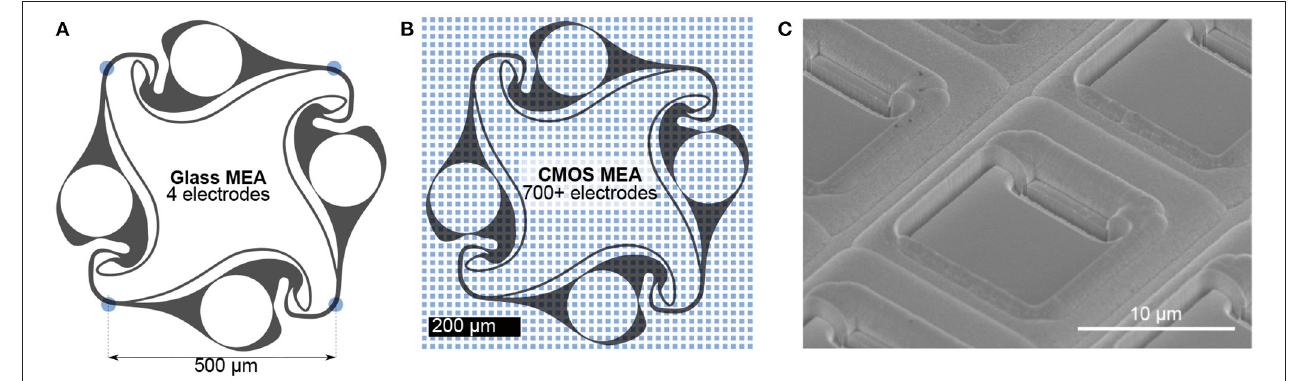
FIGURE 1 | Comparison of recording electrode densities on 60-channel glass MEAs and CMOS MEAs. (A) Commonly used 60-channel glass MEAs allow for simultaneous recording from an engineered biological neural network at 4 electrodes (blue dots) located at the microstructure channels. (B) The same microstructure on a CMOS MEA is covered with more than 700 electrodes, allowing for both axonal and somatic signal acquisition. (C) Electron micrograph of the chip surface. While the glass MEAs are flat, the surface of the CMOS MEA is non-planar due to recessed electrodes and trenches between columns of electrodes. Such a surface topology impairs the adhesion of the PDMS microstructure to the surface compromising its cell and axon guidance